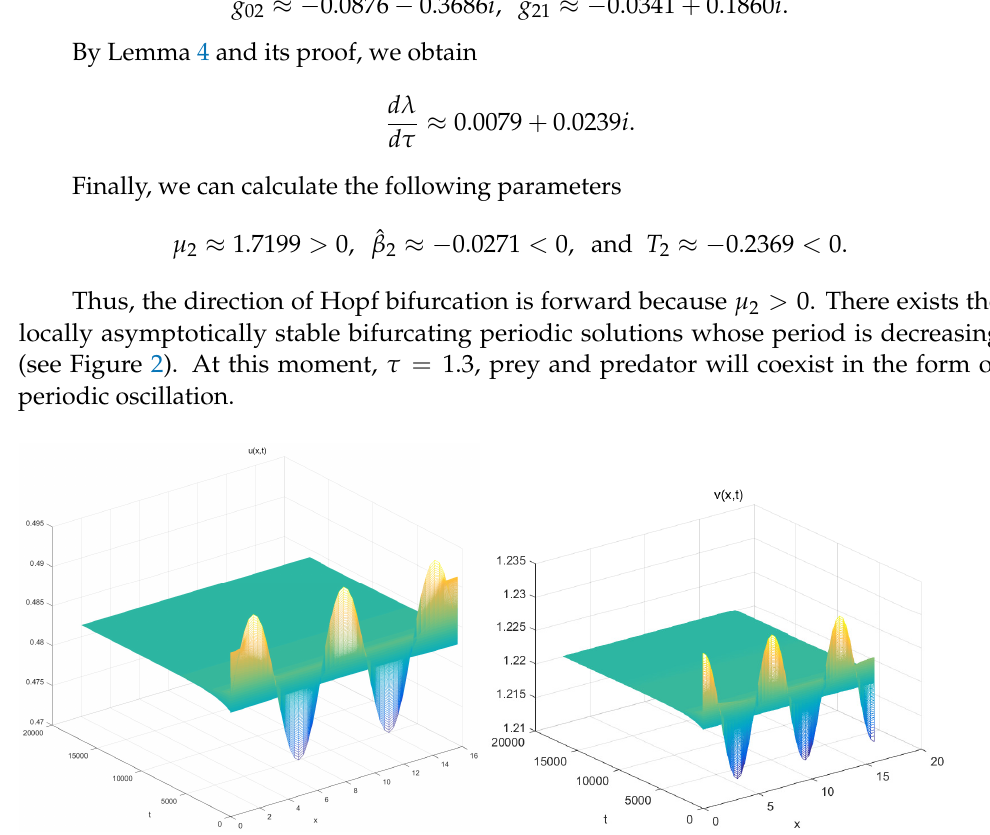
Figure 1. The numerical simulations of system (3) with τ = 0.5 and other parameters is given by (51). Left : component u . Right : component v